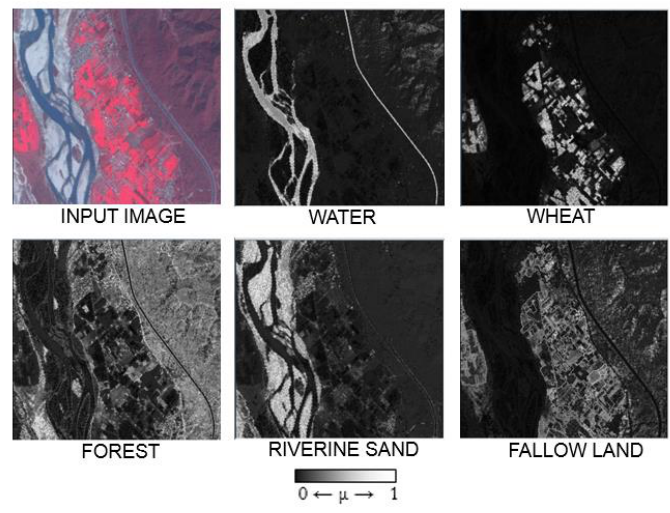
Figure 6. The result of real image using Cosine measure with m* equals 2.7.